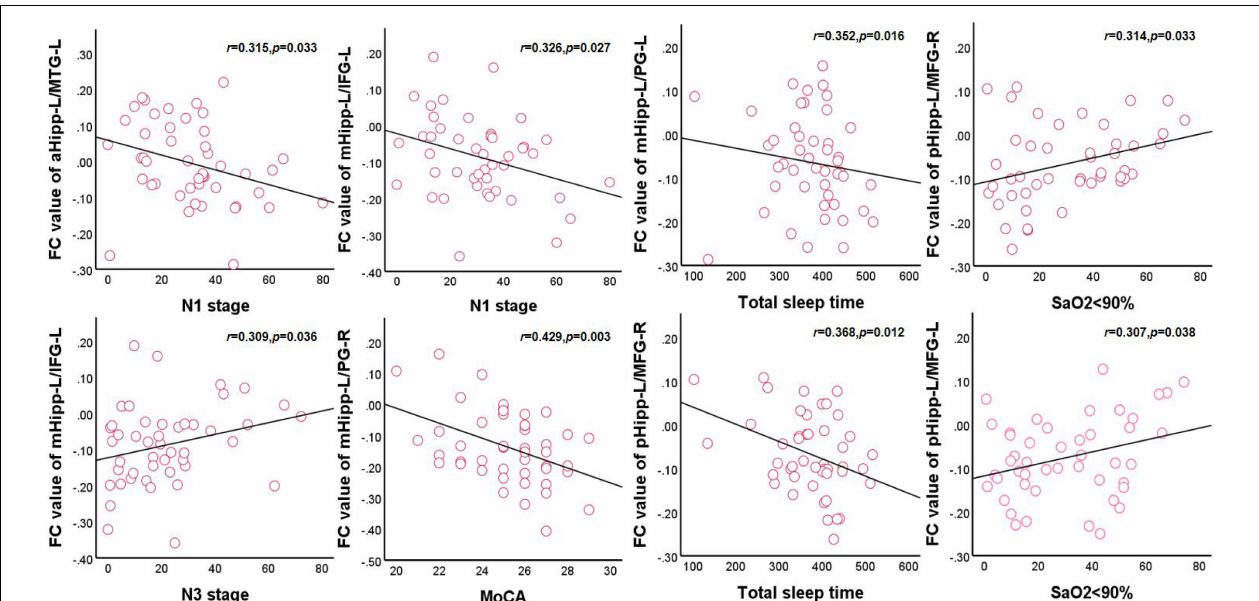
FIGURE 4 | Correlations between hippocampal FC and sleep respiratory parameters and cognitive assessment scale in OSA. aHipp-L/MTG-L, left anterior hippocampus and left middle temporal gyrus; mHipp-L/IFG-L, left middle hippocampus and left inferior frontal gyrus; mHipp-L/PG-R, left middle hippocampus and right precentral gyrus; pHipp-L/MFG-R, left posterior hippocampus and right middle frontal gyrus; pHipp-L/MFG-L, left posterior hippocampus and left middle frontal